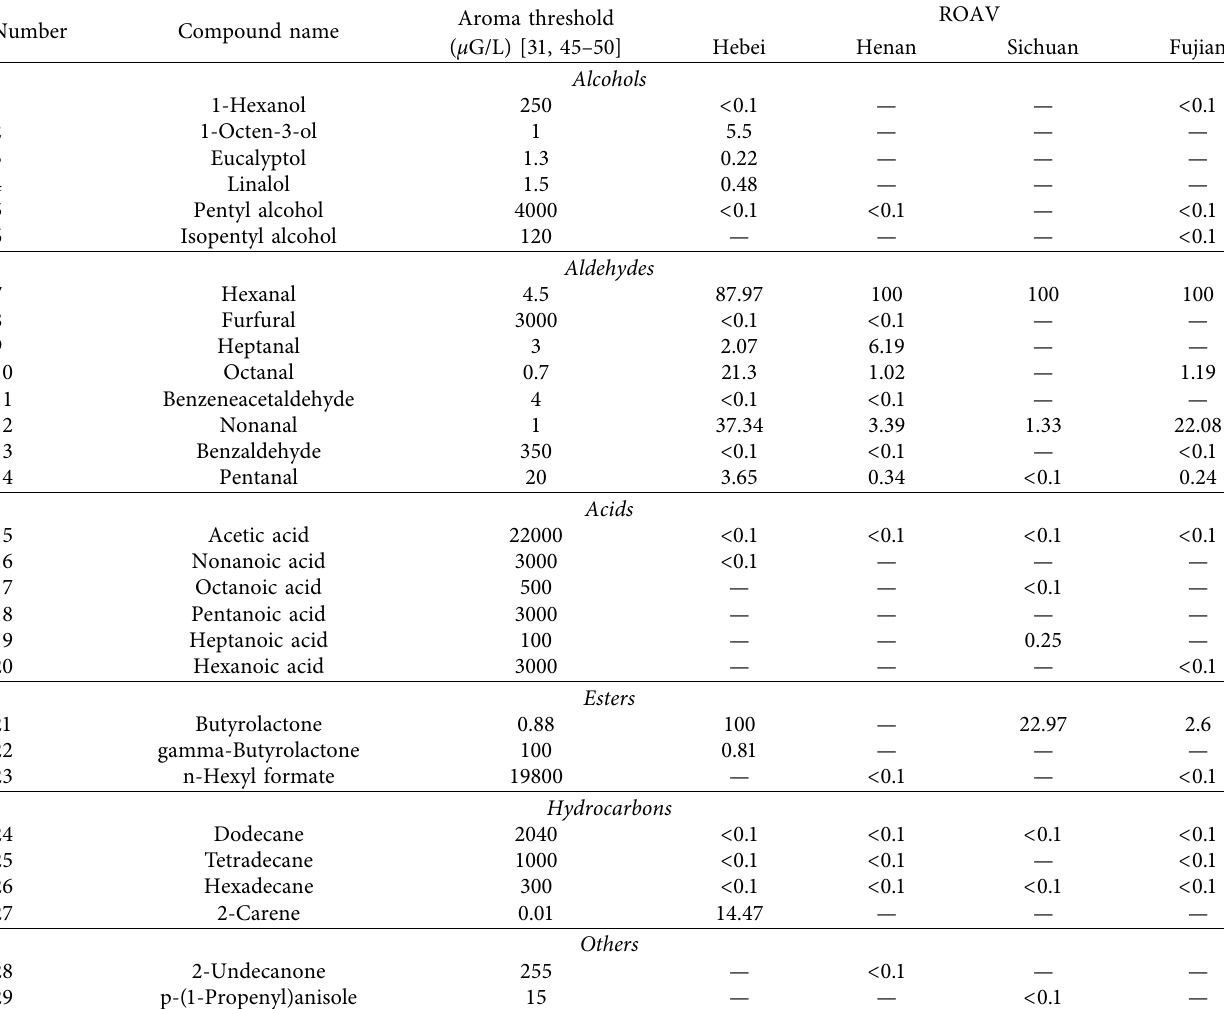
Table 3: ROAV value of 29 components in T . fuciformis from different